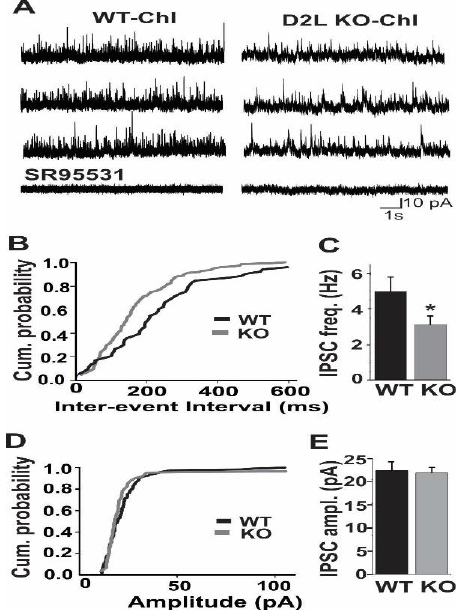
Figure 4. The frequency of mIPSCs in ChIs was significantly reduced in D2L KO mice. ( A ) Repre- sentative current traces recorded from ChIs of WT and D2L KO mice. mIPSCs were eleminated by SR95531, a GABA receptor antagonist. Cumulative probability plot ( B ) and summarized bar graph ( C ) reveal a significant reduction in mIPSC frequency in D2L KO mice ( n = 8, * p < 0.01), compared with WT mice ( n = 11). Cumulative probability plot ( D ) and summarized bar graph ( E ) reveal there is no significant difference in mIPSC amplitude between WT and D2L KO mice. WT (Black lines or bars) and D2L KO (Grey lines or bars).